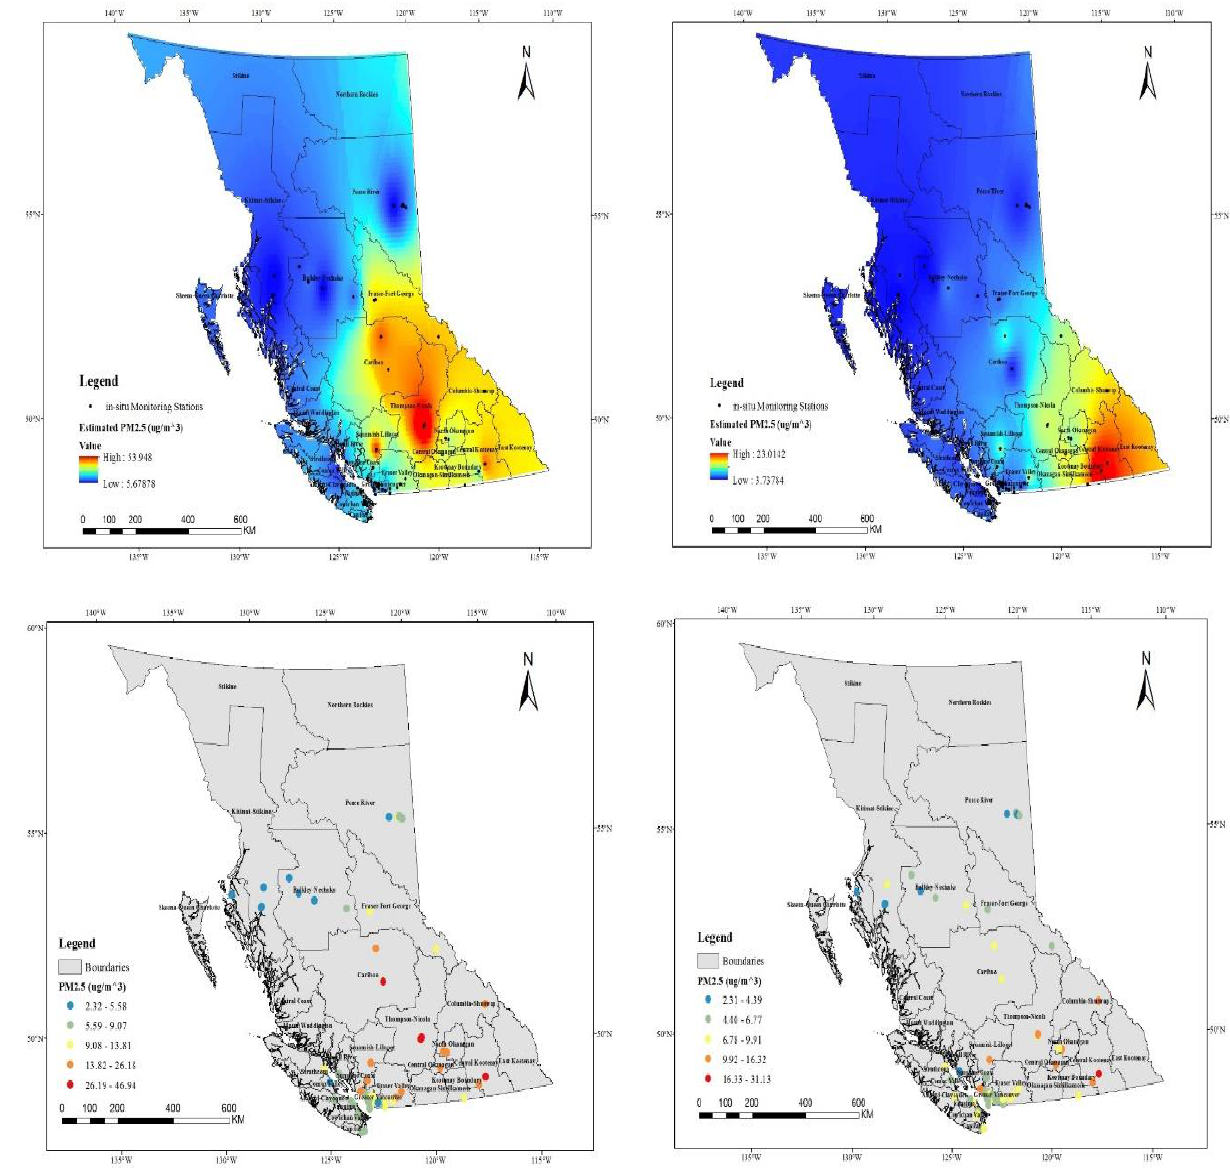
Fig. 6. Estimated PM 2.5 generated by the seasonal GWR model in fall (top); and averaged PM 2.5 concentrations from ground monitoring stations in fall